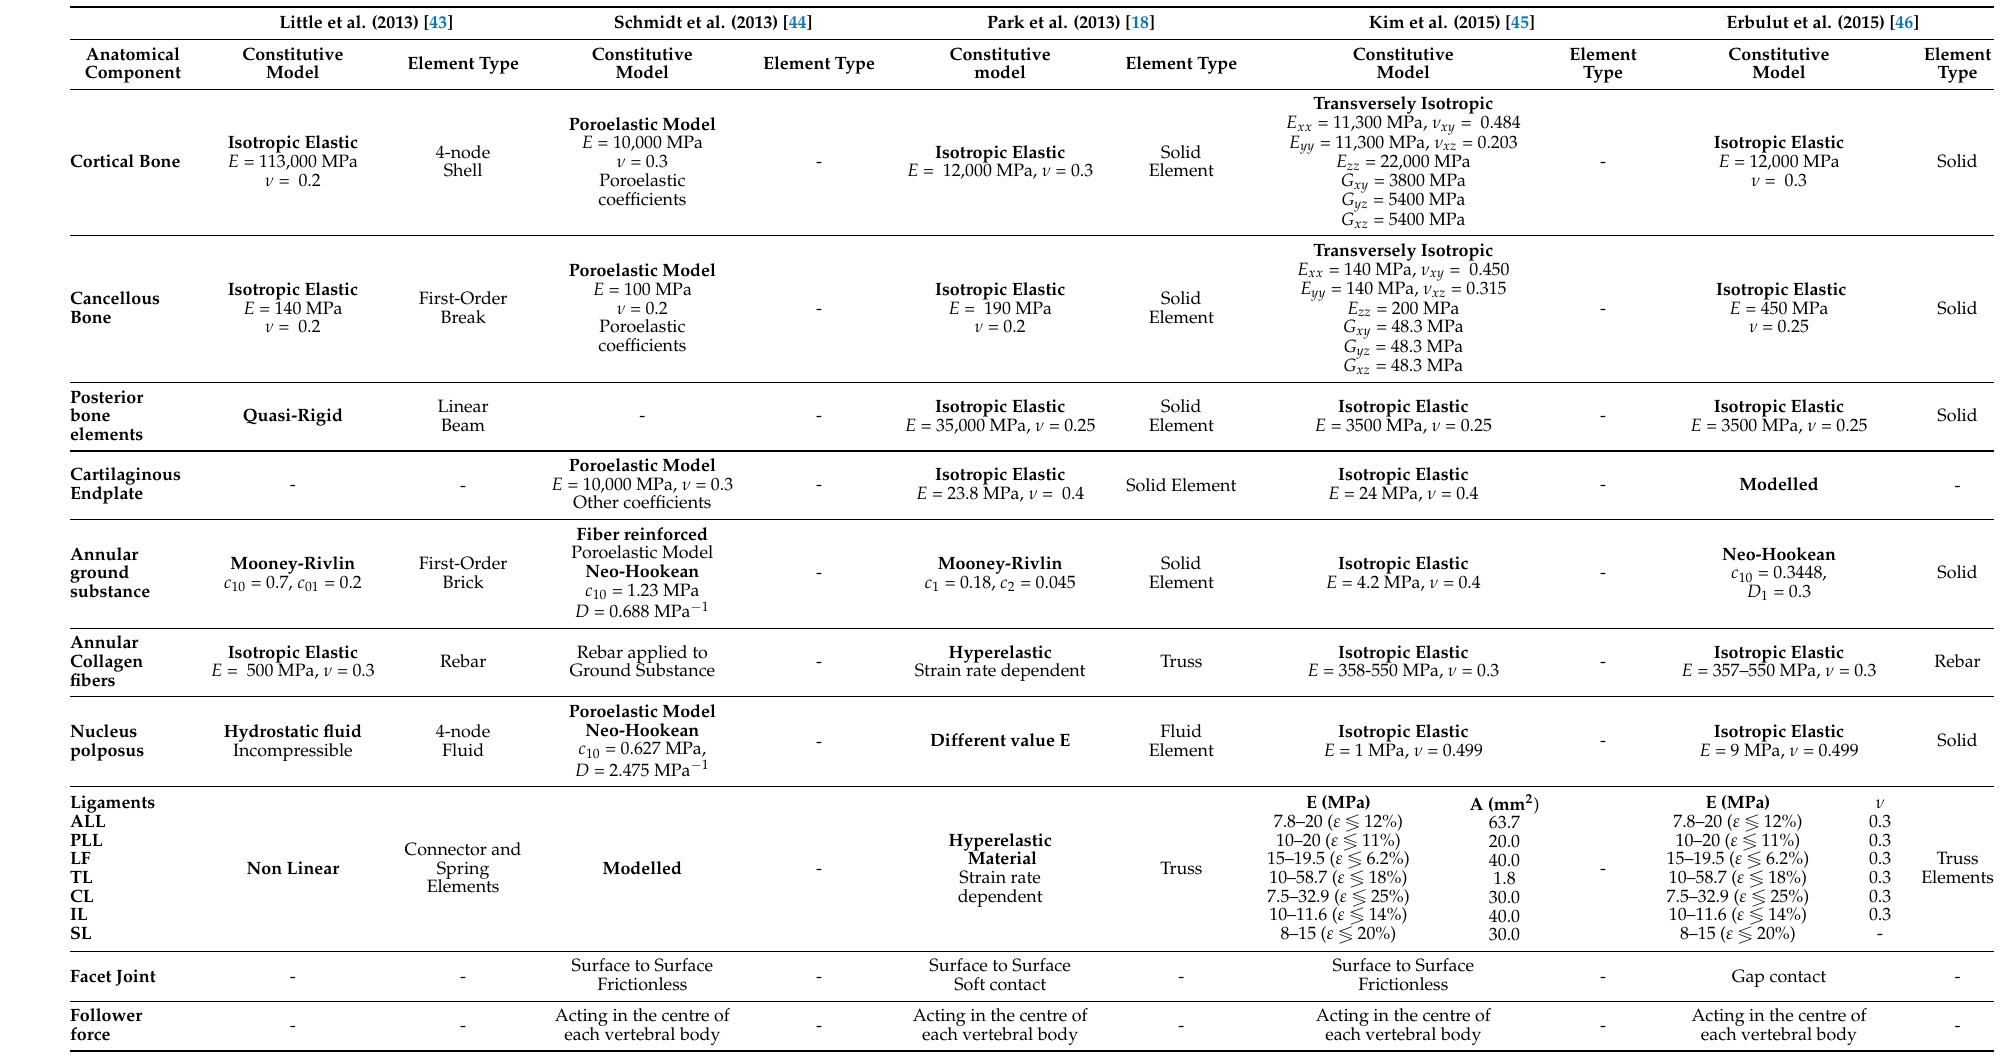
Table A3. The main information extracted from